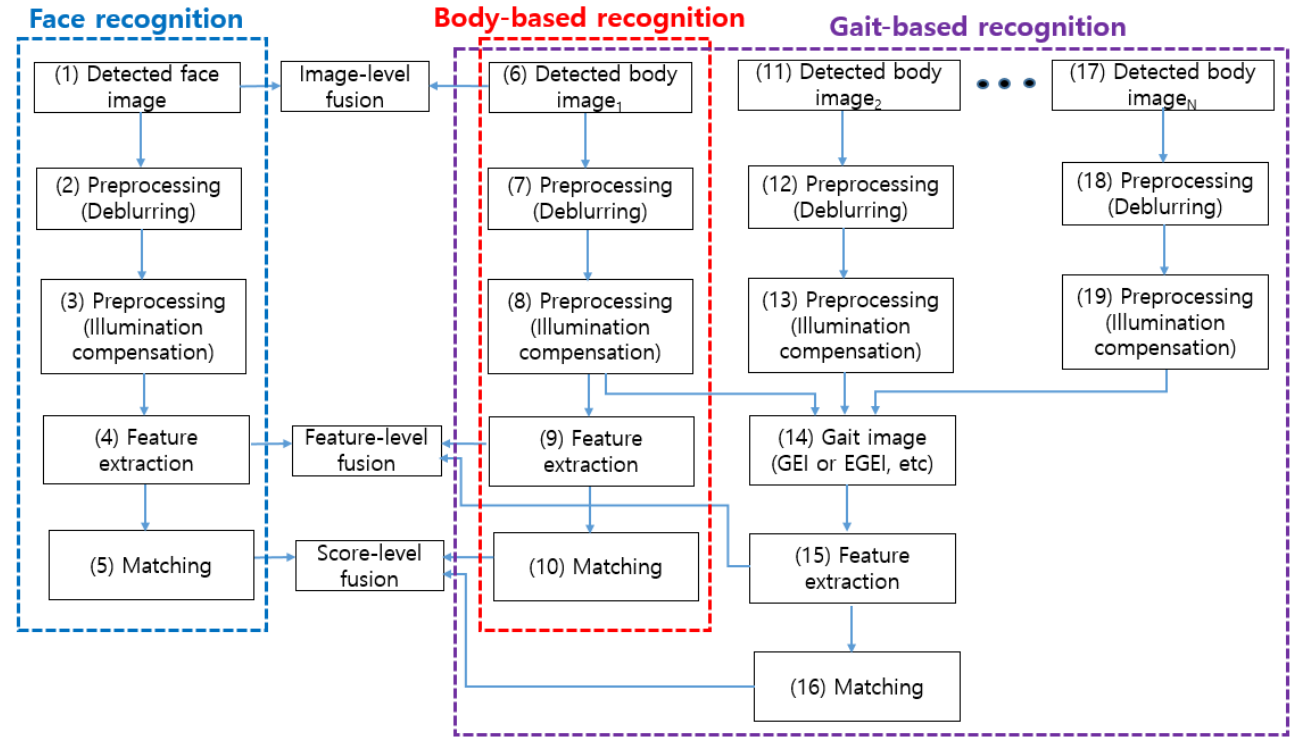
Figure 3. Overall procedure for face recognition and body- and gait-based human recognition ro- bust to image blurring and low illumination (the scope of the studies covered in this